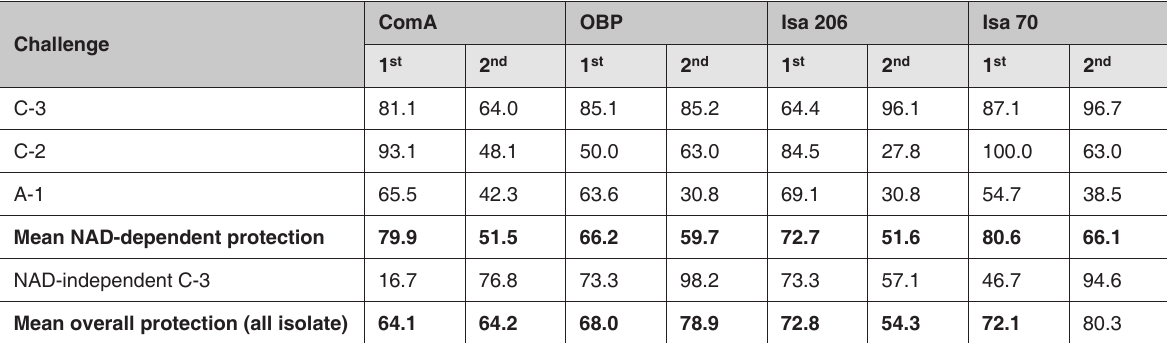
TABLE 4 Comparison of all of the vaccines based on percentage protection against the NAD-dependent, NAD-independent strain and for all of the challenge strains used (excluding serovar B-1, which did not result in any clinical signs when used to challenge chickens in this experiment, including the unvaccinated controls). Mean protections obtained for the first and second round of challenges for all of the vaccines and challenged strains used in this experiment are also